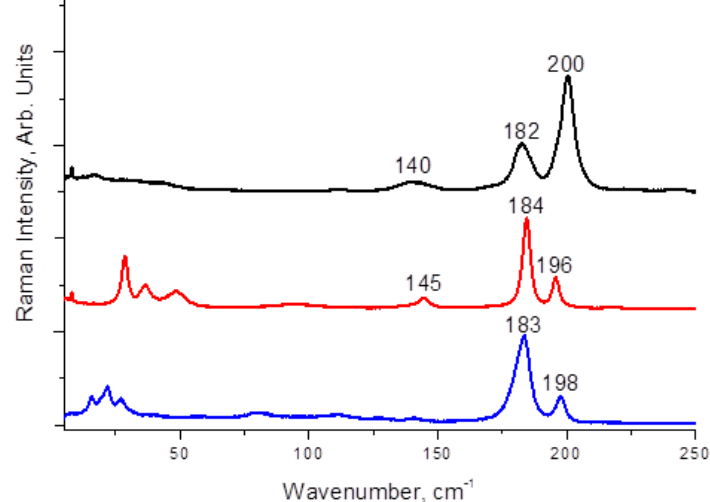
Figure 3. Raman spectra of 1 (black), red ( 2 ), and blue ( 3 ).